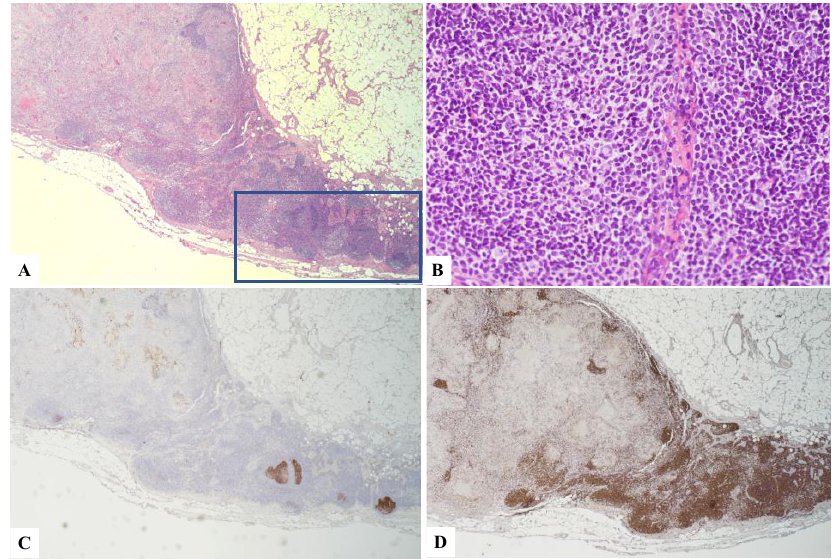
Figure 7. ( A ) H&E original magnification 2.5x of the axillary lymph node displaying an area with well-formed granulomas, and in the remaining part of the lymphoid tissue, follicular hyperplasia was observed with two atypical follicles (blue rectangle). ( B ) H&E original magnification 40x of one of the atypical follicles suggestive of ISFN. ( C ) CD10+. ( D ) BCL2+.